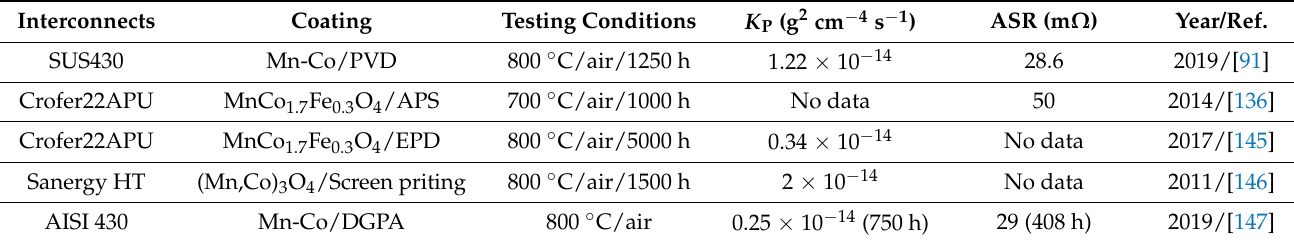
Table 3. Coatings of the